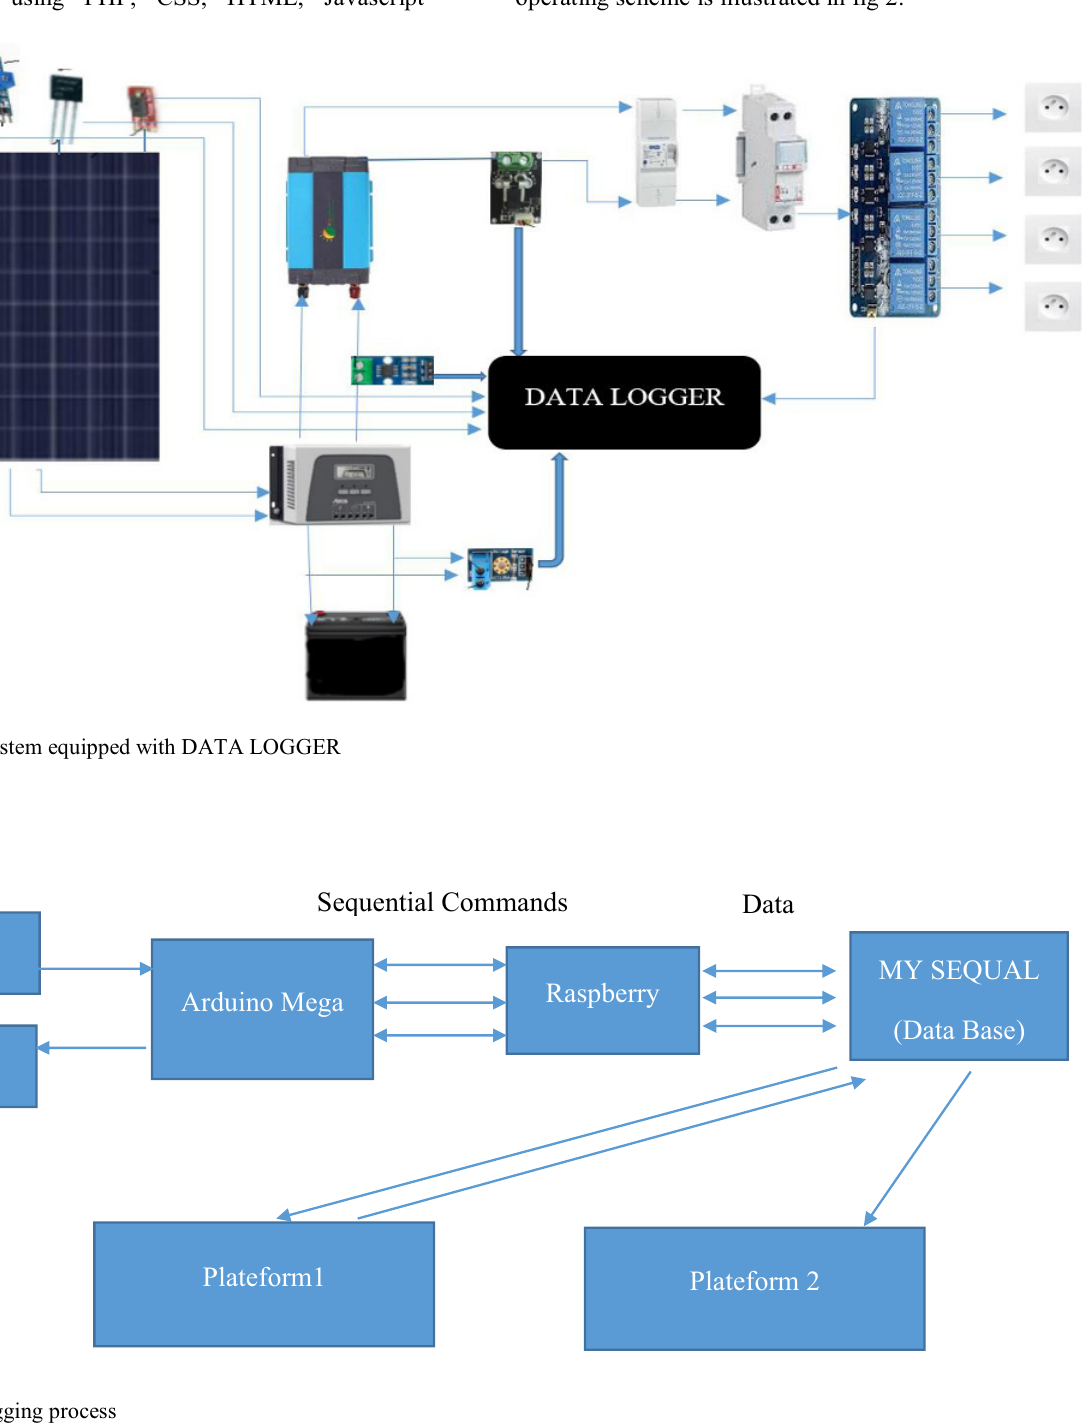
Fig. 2 Data logging